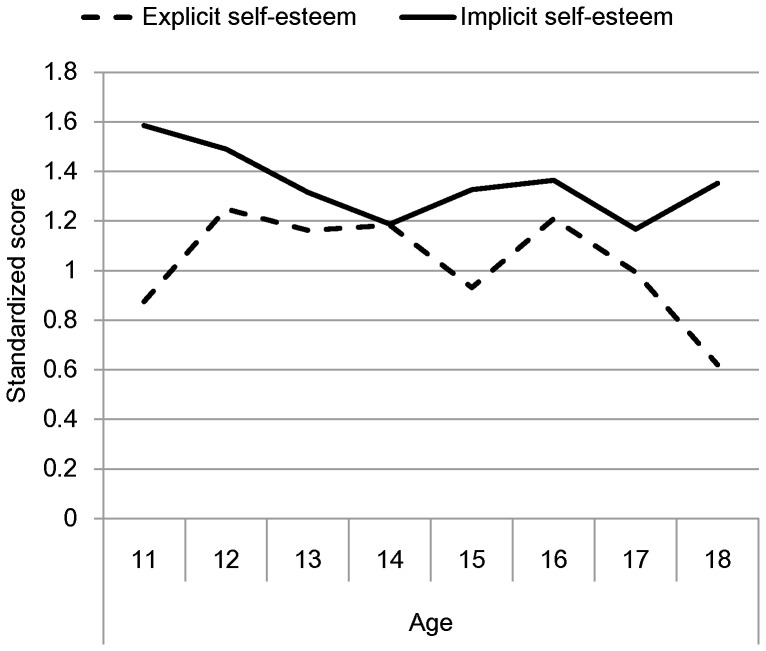
The standardized implicit and explicit self-esteem by ages.